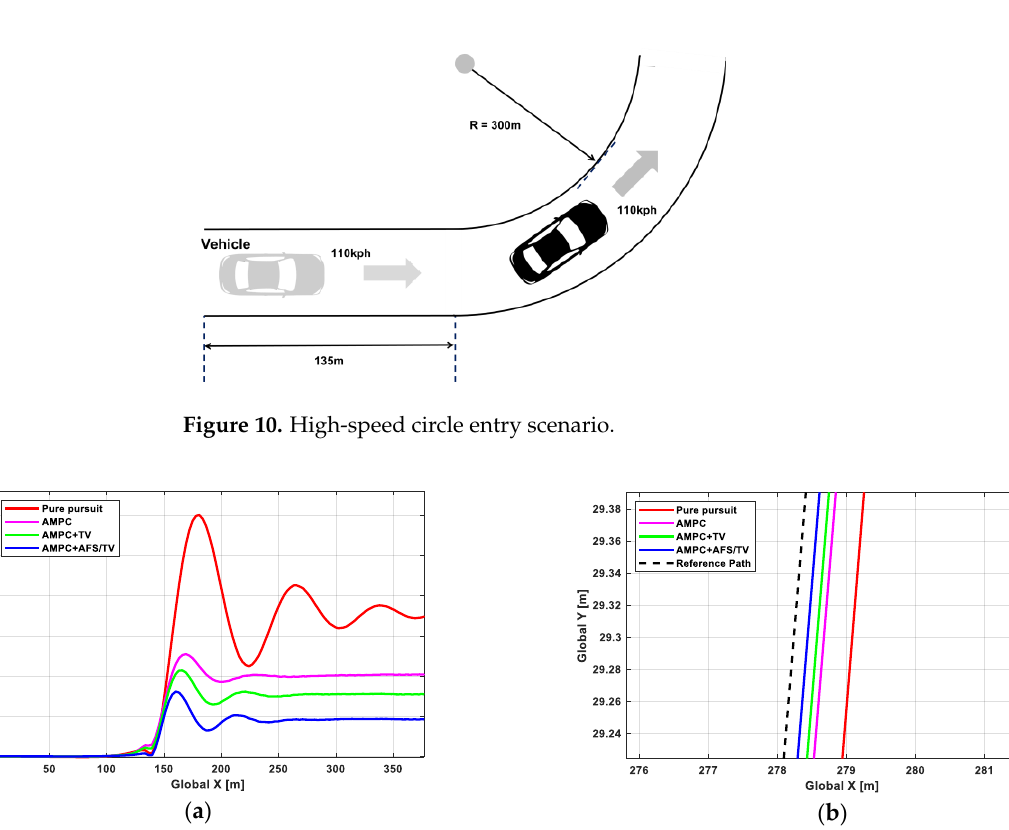
( d ) Figure 9. Independent in-wheel motors (IWM) torque: ( a ) front-left, ( b ) front-right, ( c ) rear-left, and ( d ) rear-right. As can be seen in Figure 9b, AMPC + AFS/TV uses much less torque than AMPC + TV to carry out the same double lane change maneuver. The graphs for AMPC + TV show that the torques at the front-left and rear-left tires saturate to their limits for an in- terval, but this does not occur for AMPC + AFS/TV. In AMPC + TV, the torque profiles